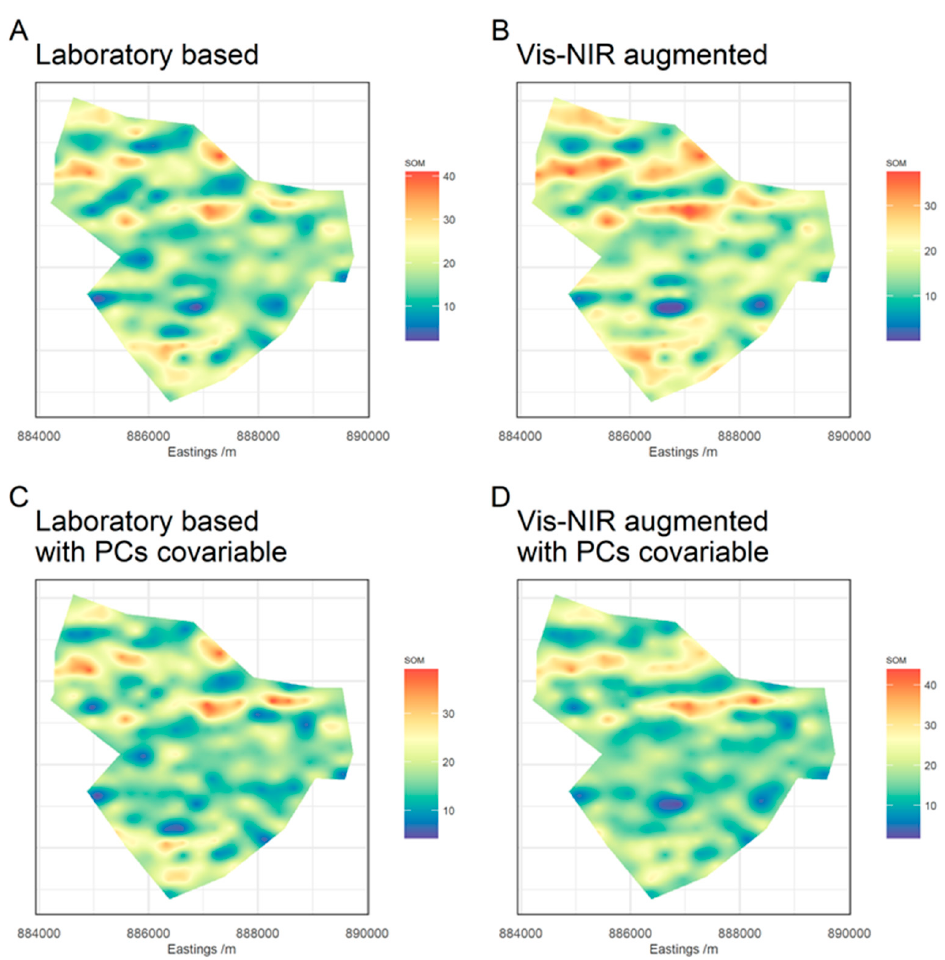
Figure 7. Maps of SOM generated from the data of the laboratory-based (Lb) ( A ), vis-NIR augmented datasets (Au.p) ( B ), the laboratory-based with pcs covariate (Ld.co) ( C ), vis-NIR augmented datasets with pcs covariate (Au.p.co) ( D ).